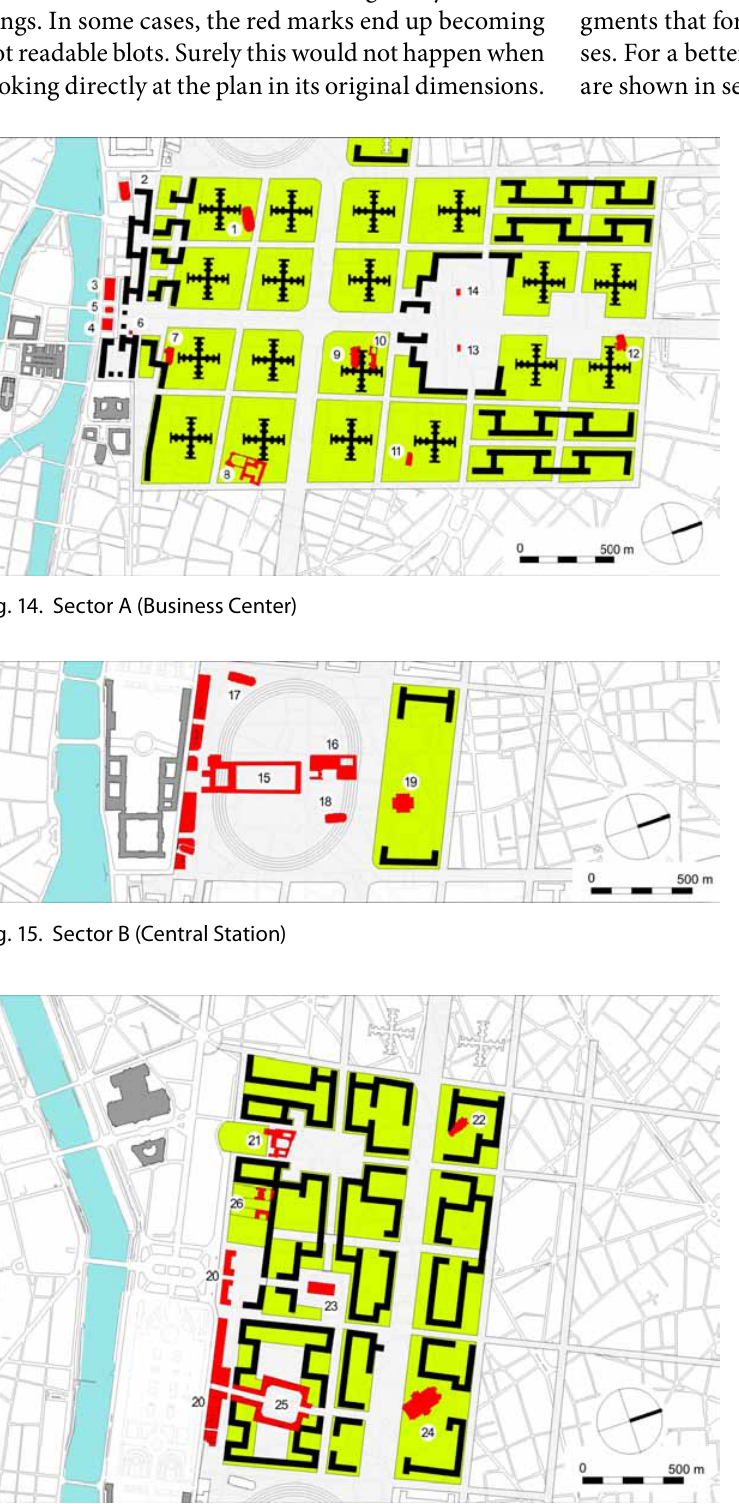
fig. 16. Sector C (residential